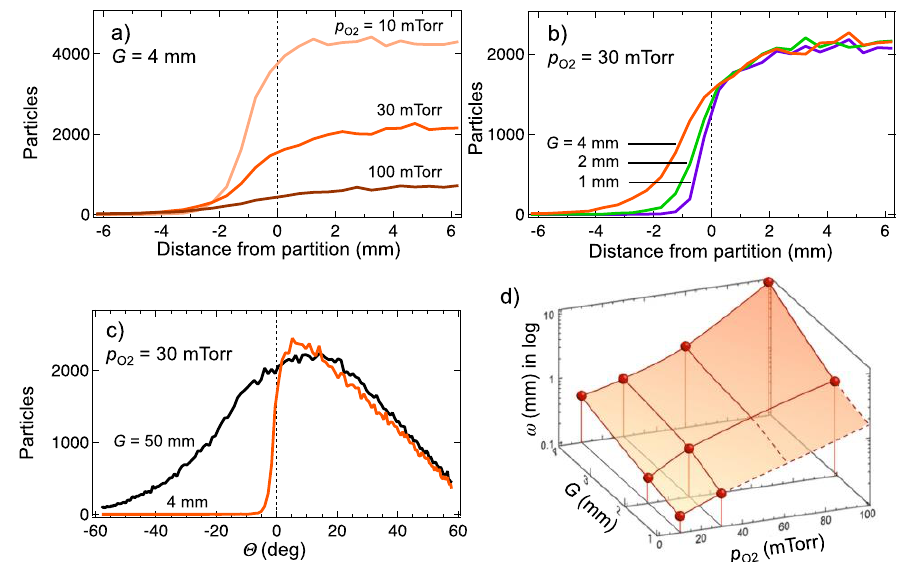
Figure 3. ( a )–( c ) Simulated distribution of particles ablated under various oxygen pressures and gaps. ( a ) Pressure dependency with a fixed gap of 4 mm. ( b ) Gap dependency with a fixed pressure of 30 mTorr. ( c ) Comparison between cases with and without the partition. G = 50 mm corresponds to the case without the partition. ( d ) 3D-plot of ω values, extracted from fitting to experimental Ce distribution (Figure 2), as a function of gap and oxygen pressure. Red balls represent the extracted values. Curved lines and filling color are guides to the eyes.